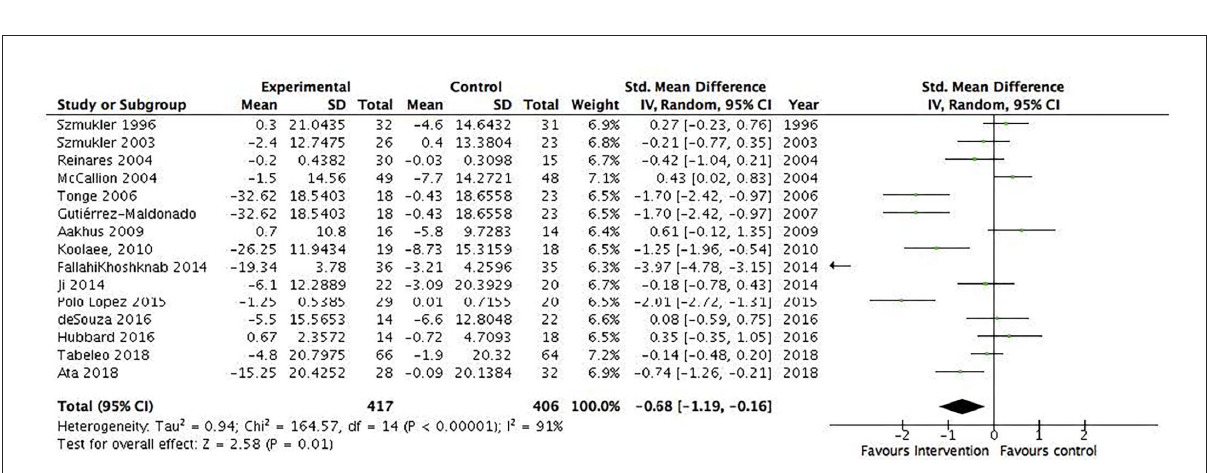
FIGURE5 Subgroup analysis of interventions for informal caregivers of people with severe mental illness, group/individual: All studies. Mean within-group changes and standardized mean